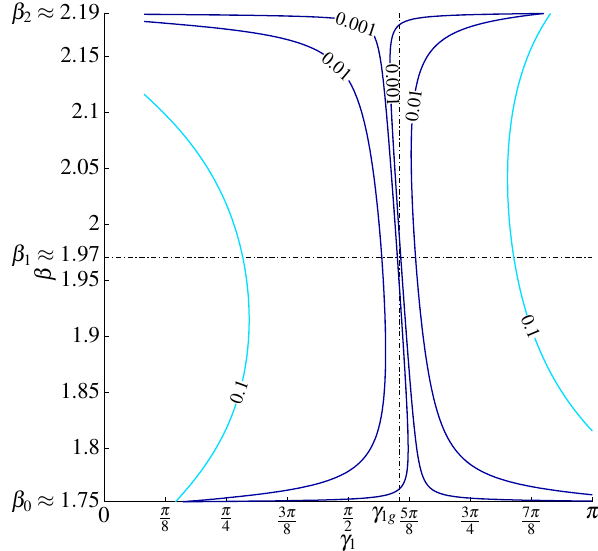
Figure 14. Error e γ as a function of γ 1 and β .